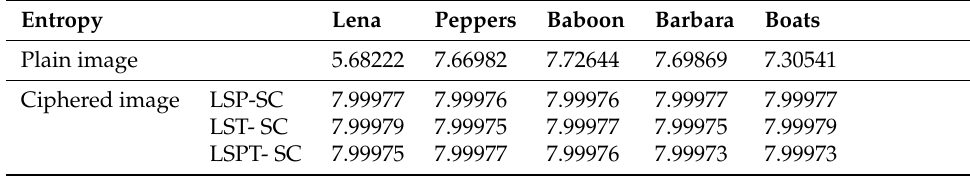
Table 10. Entropy results obtained.